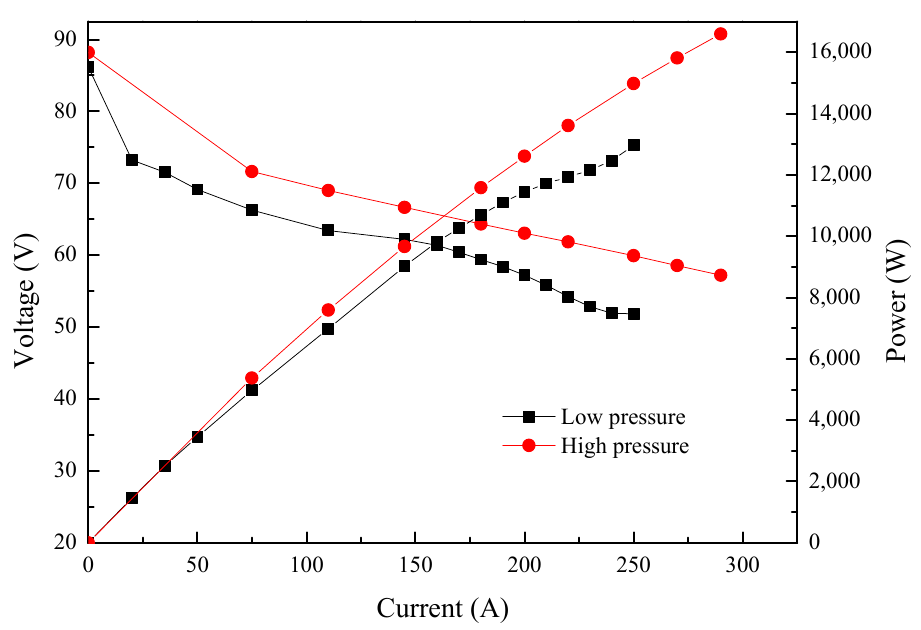
Figure 1. Performance of the PEMFC stack.